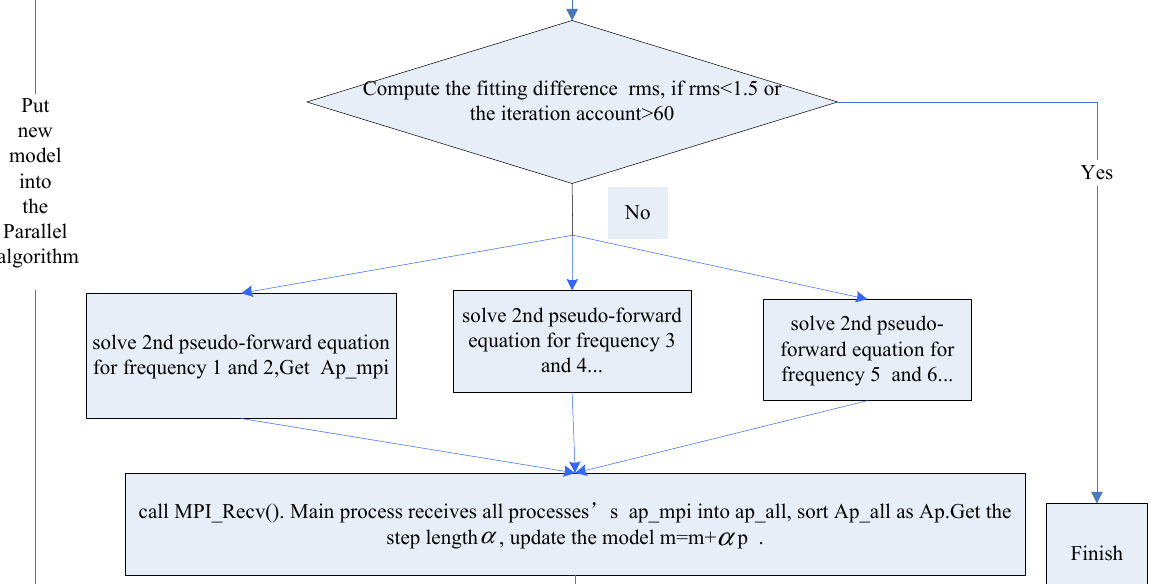
Figure 2. The flow chart of parallel computing for 2D magnetotelluric.